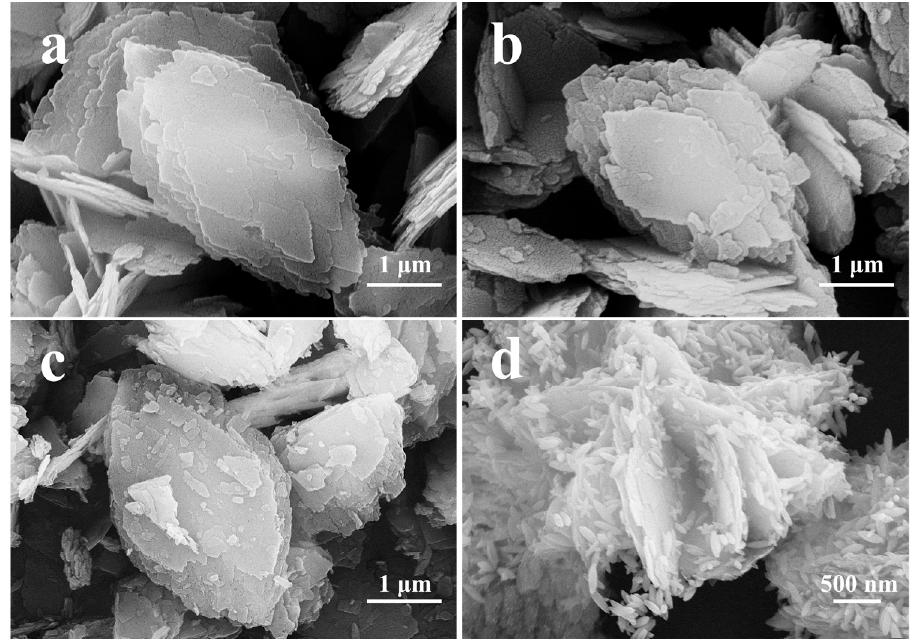
Figure 2. SEM images of CP ( a ), Fe(0.03) − H(0.05) − CP − 3 ( b ), Fe(0.03) − H(0.05) − CP − 9 ( c ), and Fe(0.03) − H(0.00) − CP − 9 ( d ).